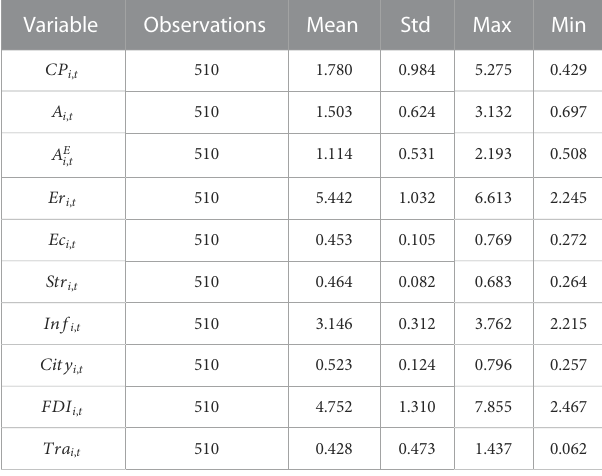
TABLE 2 Summary statistics of variables. Variable